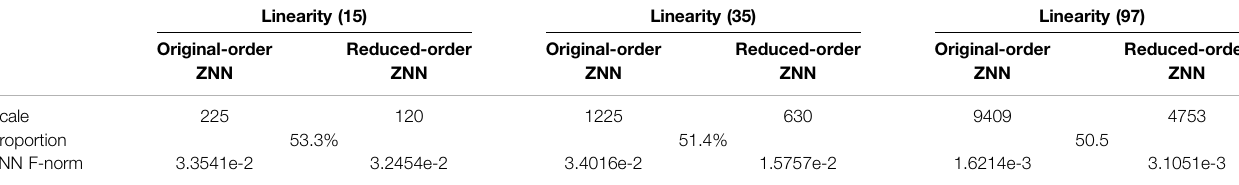
TABLE 5 | Comparison of the original-order ZNN and the reduced-order ZNN under Examples